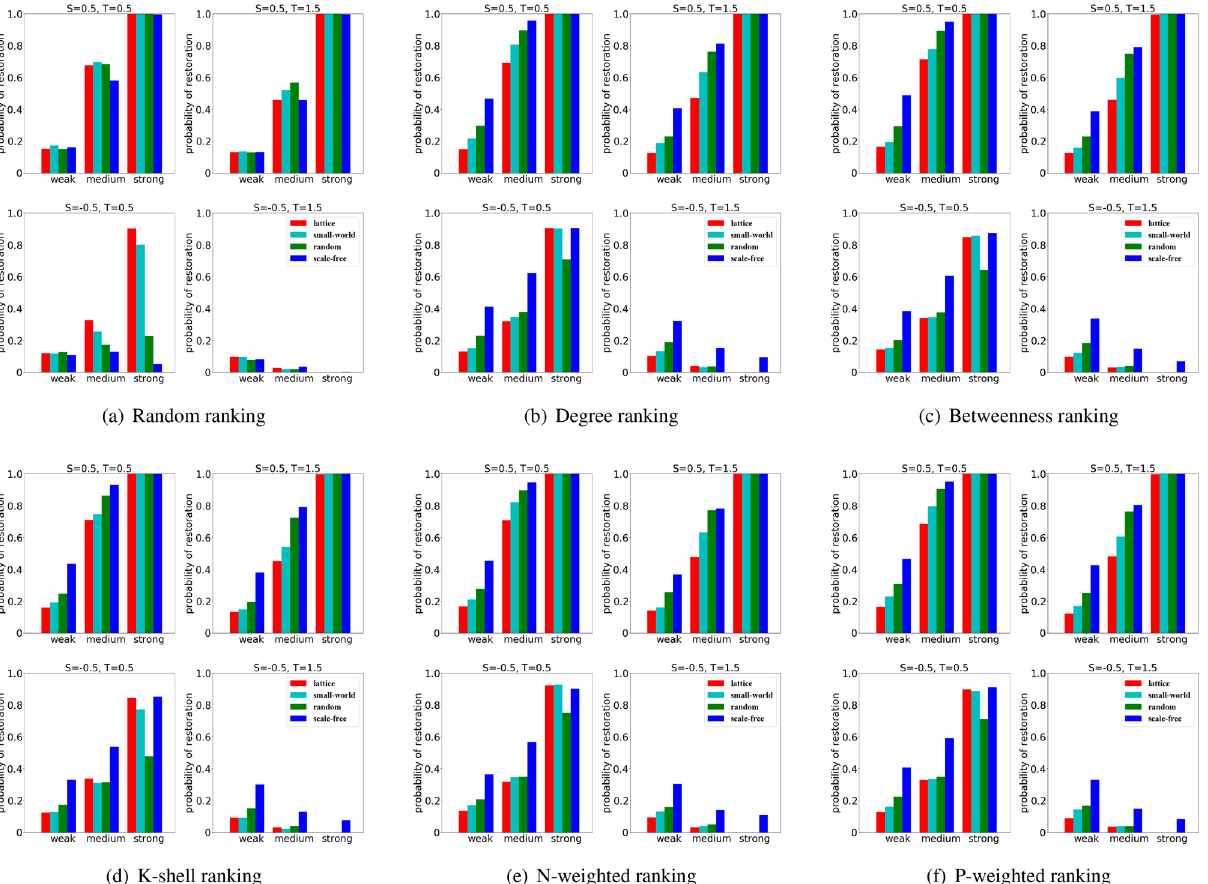
Figure 7. Strong selection weakens the performance of random ranking but enhances the performance of structural rankings in scale-free networks for stag-hunt games. More generally, the increase of degree diversity in the network structure facilitates the restoration of cooperation when the initial cooperators are added using structural rankings. For a fixed initial density ρ = 10% , we show the probability of cooperation restoration obtained in a lattice, small-world, random and scale-free networks, at weak selection ( w = 0.001 ), medium selection ( w = 0.01 ) and strong selection ( w = 0.1 ). For completeness we consider all six ranking strategies ( S = − 0.5 and T = 1.5 ), harmony game ( S = 0.5 and T = 0.5 ) and snowdrift game ( S = 0.5 and T = 1.5